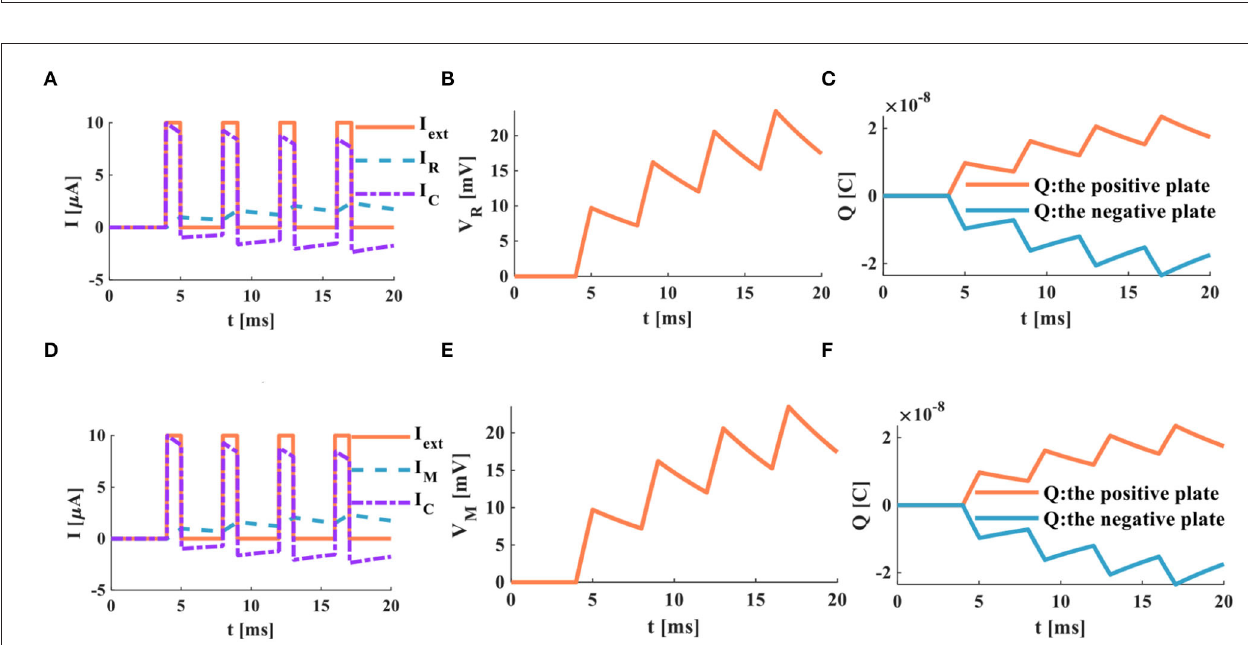
FIGURE 12 | A series of current pulses act on the RC and the MC neuron circuits (the number of the external stimuli is 4, the action time is 1,000 ms ), (A) the current flows through the resistor R and the capacitor C, (B) the membrane potential of the RC circuit, (C) the charges on the positive and negative plates in the RC circuit, (D) the current flows through the memristor M and the capacitor C, (E) the membrane potential of the MC circuit, (F) the charges on the positive and negative plates in the MC circuit.